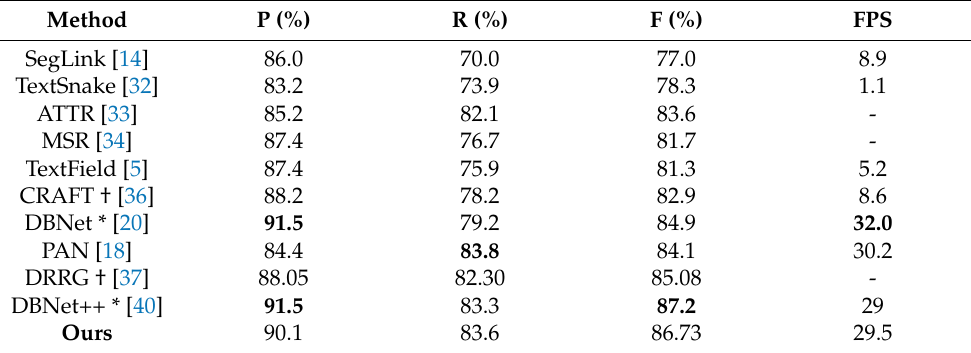
Table 3. Detection results on the MSRA-TD500 dataset. “*” indicates using deformable-ResNet-50 as backbone and “†” indicates using external MLT17 data for pre-training. The best performance is given in